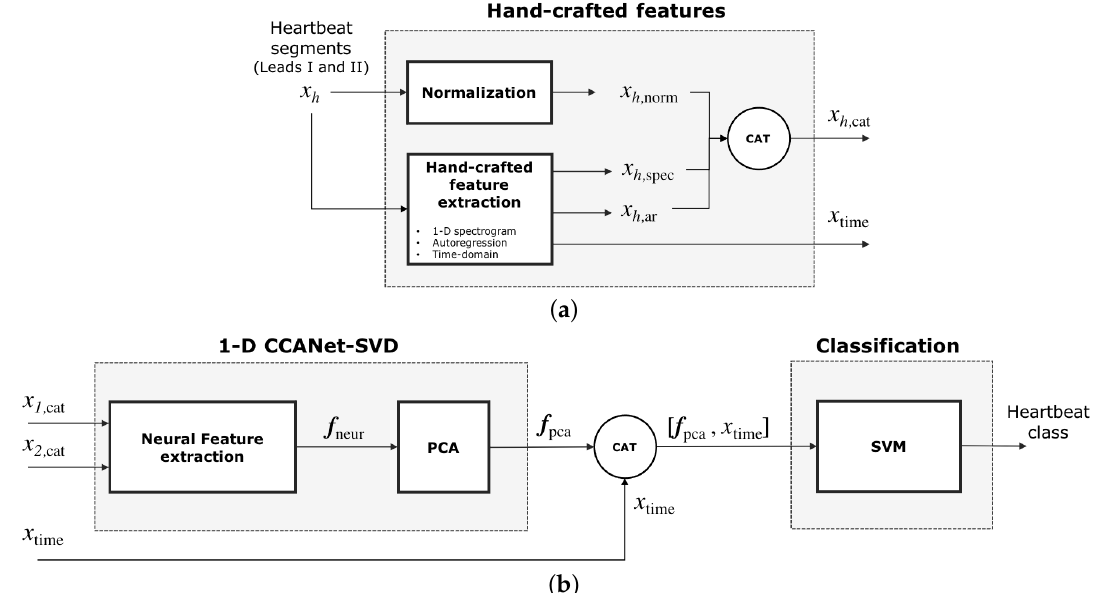
Figure 1. Classification processing pipeline of our method. ( a ) Feature extraction: for each of the two leads x h ( h = 1,2 ) , hand-crafted features are extracted to build x h ,cat ( h = 1,2 ) while x time , a vector of time-domain features, is built for both leads. ( b ) Part of these features, x h ,cat ( h = 1,2 ) , feeds the 1-D CCANet-SVD module, which first outputs the neural features f neur and then a reduced version of the neural features f pca . The concatenation of x time and f pca feeds the classification module. The output is the predicted heartbeat